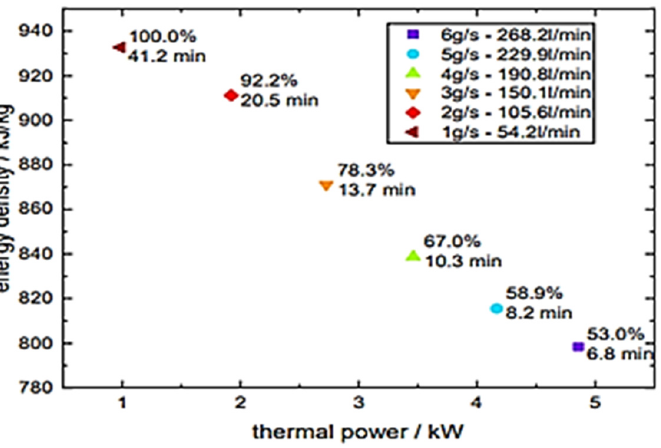
Figure 13. Thermal power of the MBR for the steady-state case and energy density of the material with different particle and gas flow rates [136]. with different particle and gas flow rates [136].